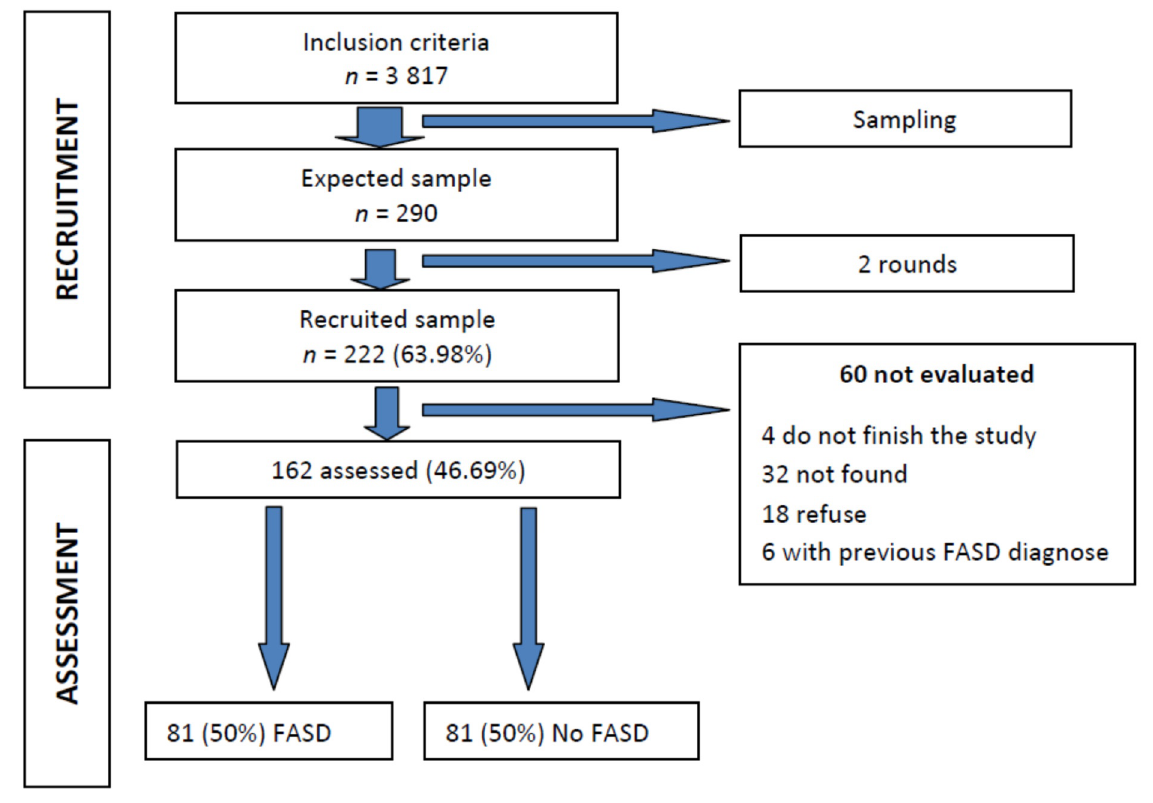
Figure 1. Flowchart of the experimental design and the selection process. Fetal alcohol spectrum disorder (FASD).